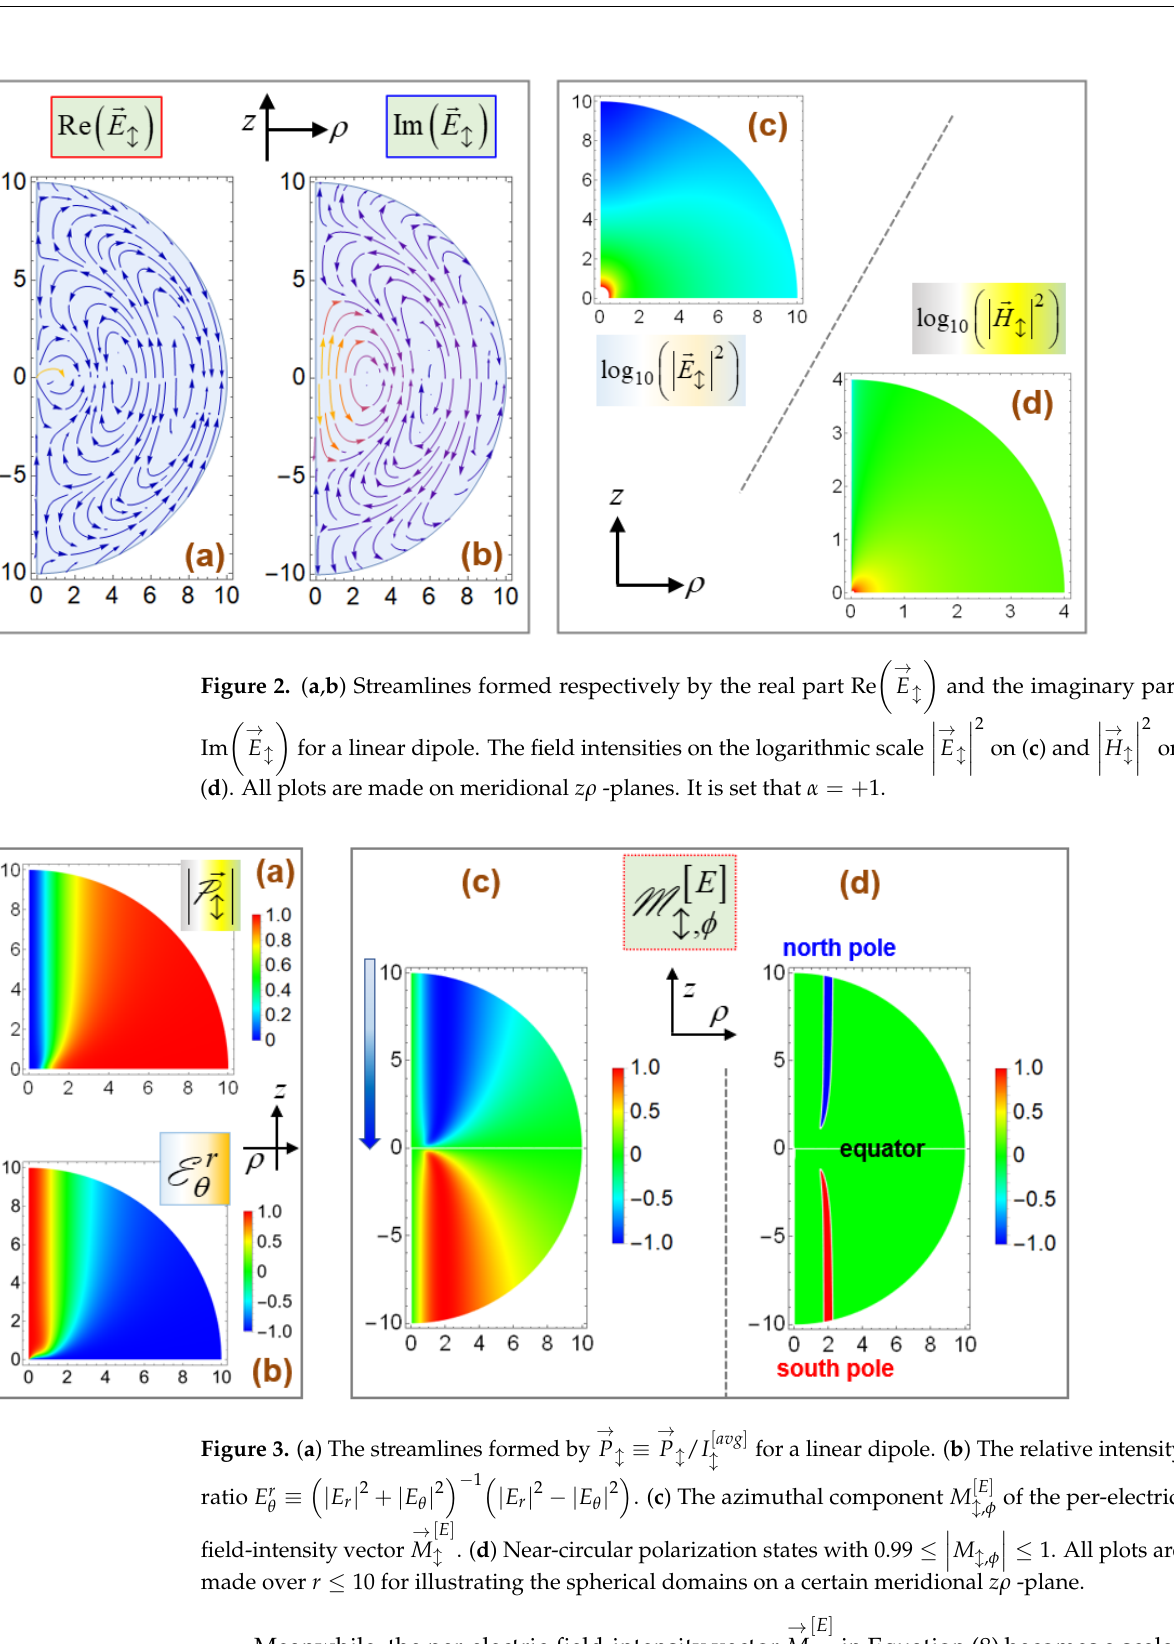
12 object. The absorptive and/or polarizable properties of those immersed nano-objects help us to come up with both EM and reactive helicities [10,12–17,19,21,23,32,37–39,41]. Another method is to measure the field intensity along two orthogonal directions [4,6]. Conversely, M ⇐ = ∇ = −∇     would help us map the electric and magnetic fields whenever the EM field under consideration is induced by the simultaneous presence of an electric dipole and a magnetic dipole. The conservation law [ ] 0 avg M ∇ =   in Equation (3) complements the fact that rotating the transverse coordinates induces opposite phase shifts in the right- and left-hand circularly polarized waves propagating along a certain axis. This relation [ ] [ ] E H M M ∇ = −∇     of Equation (3) is related to but not equal to the ‘dual-antisymmetric’ relation presented in [10]. One reason for this discrepancy in the term ‘dual-antisymmetric’ lies in the fact that [ ] [ ] 0 E H M M ∇ + ∇ =     does not always mean [ ] 0 E . Let us tell what we have achieved in this study. Although various formulas presented in Section 2 have already been scattered in the references mentioned there, we have made clearer the relationships among them as illustrated in Figure 1a. The actual formulas presented in Equations (6) and (7) have been analytically derived for the first time in this study in the two special cases of electric point dipoles. Especially, the explicit forms of the pairs of the internal energy flow, , have never been published anywhere. The following Sections 4 and 5 show numerical behaviors in appropriate coordinate frames respectively for the linear and circular electric point dipoles. 4. Numerical Evaluations of Electromagnetic Fields for a Linear Dipole Figure 2 displays the induced fields E   and the field intensities for a linear dipole [10,18,22,24,32], where EM fields themselves exhibit vortices and singularities. It is noted in Figure 2c that a dark region prevails in the vertical direction [5]. Since the SAM density [ ]